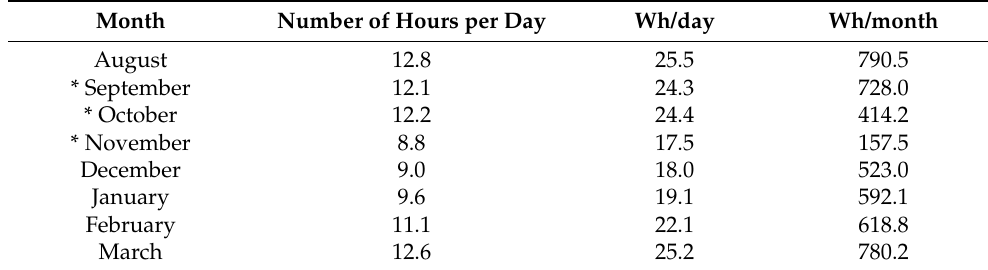
Table 7. Average daily and monthly energy consumption of the fan in the PV5 system.